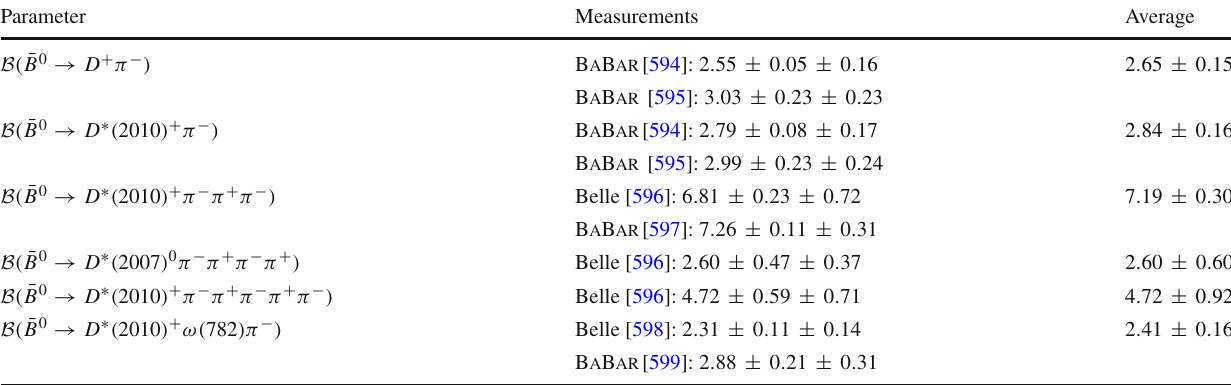
Table 94 Decays to a D ( ∗ ) meson and one or more pions II [ 10 − 4 ] Parameter Measurements Average